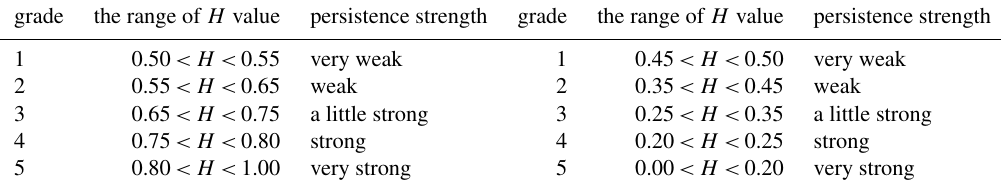
Table 1. Hurst index rating table. grade the range of H value persistence strength grade the range of H value persistence